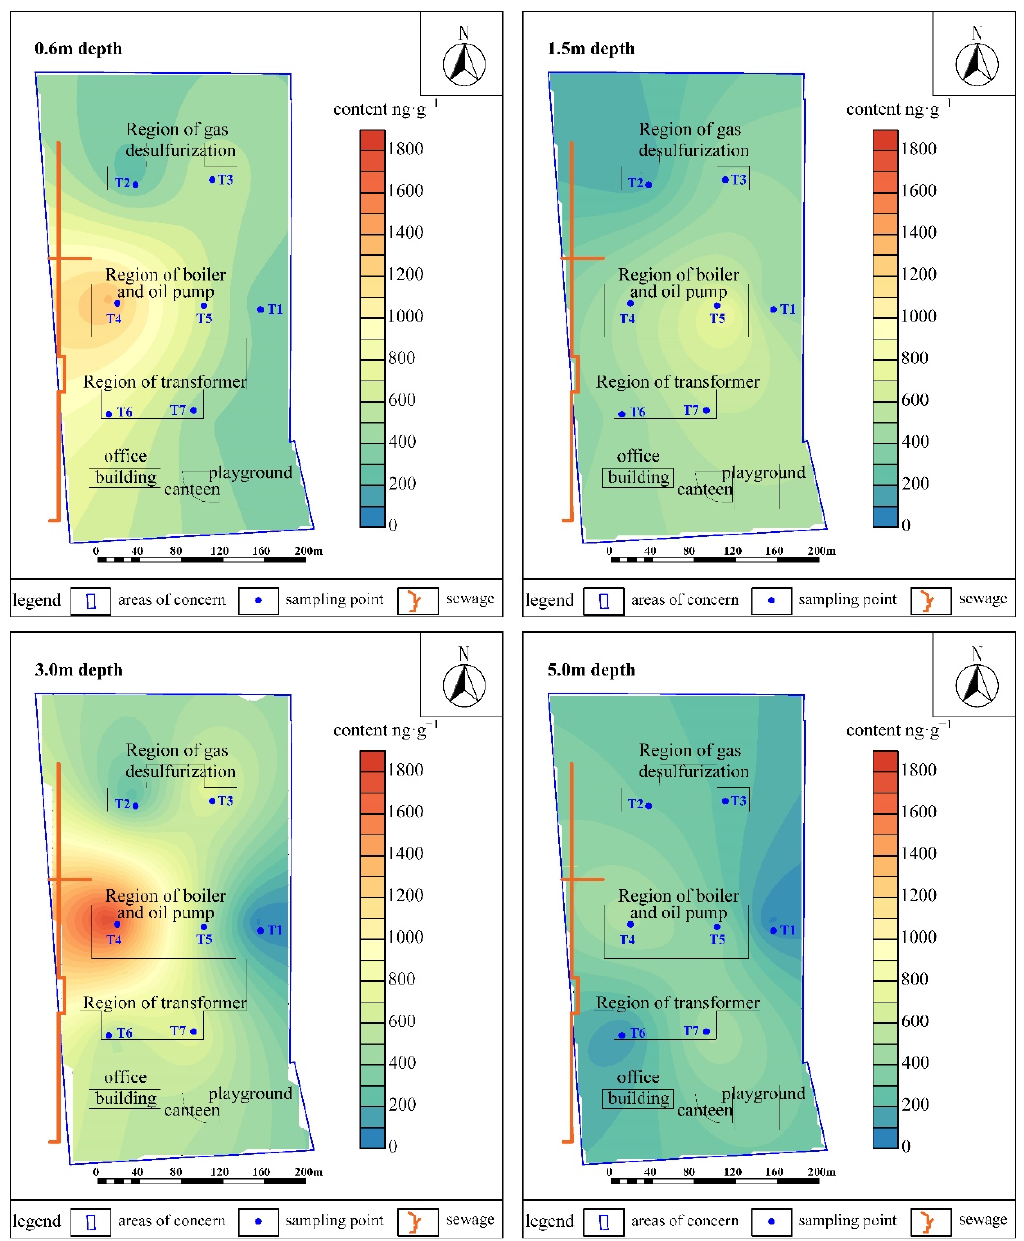
Figure 5. The contamination status of PAHs at key depths of each point collected based on the location of process unit in the legacy site.